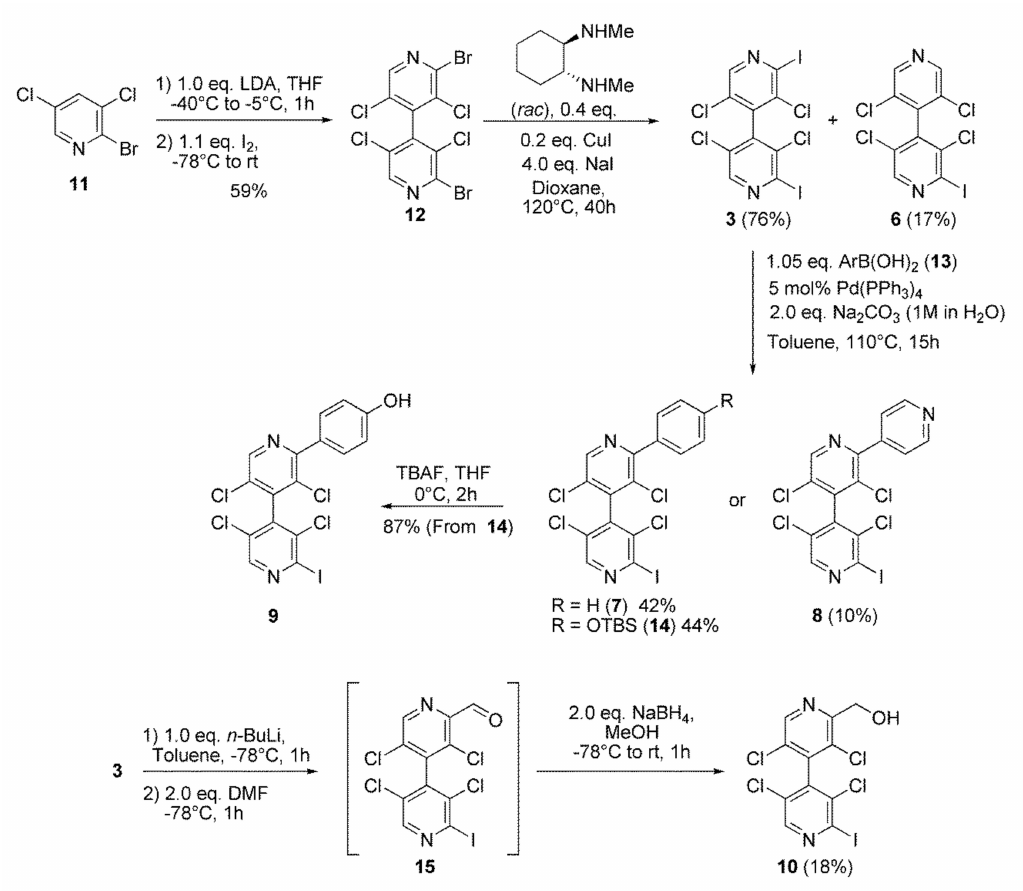
Scheme 1. Synthesis of bipyridines 6 – 10